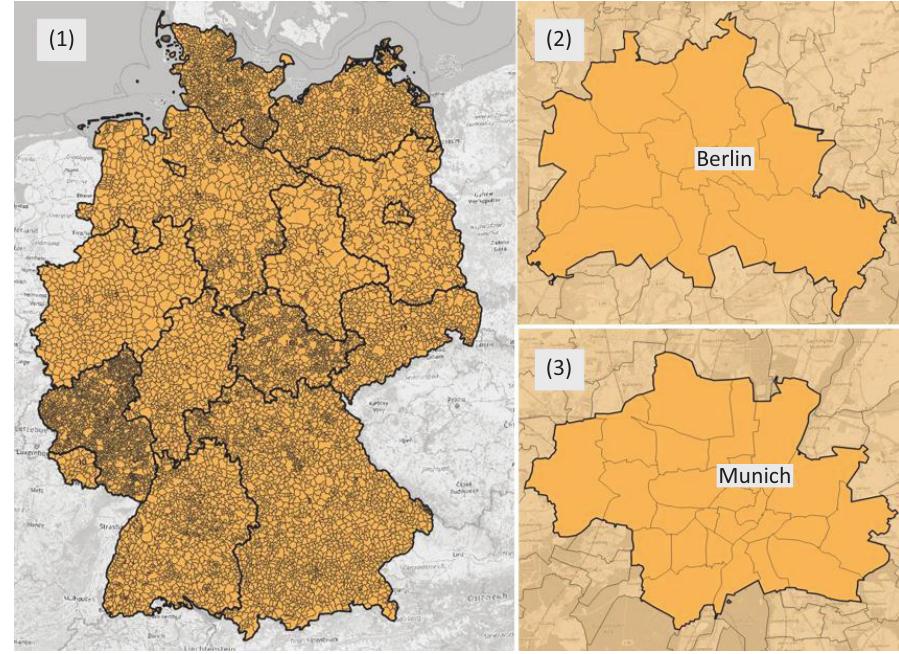
Figure 2. Zone system: (1) Germany, (2) Berlin, (3)